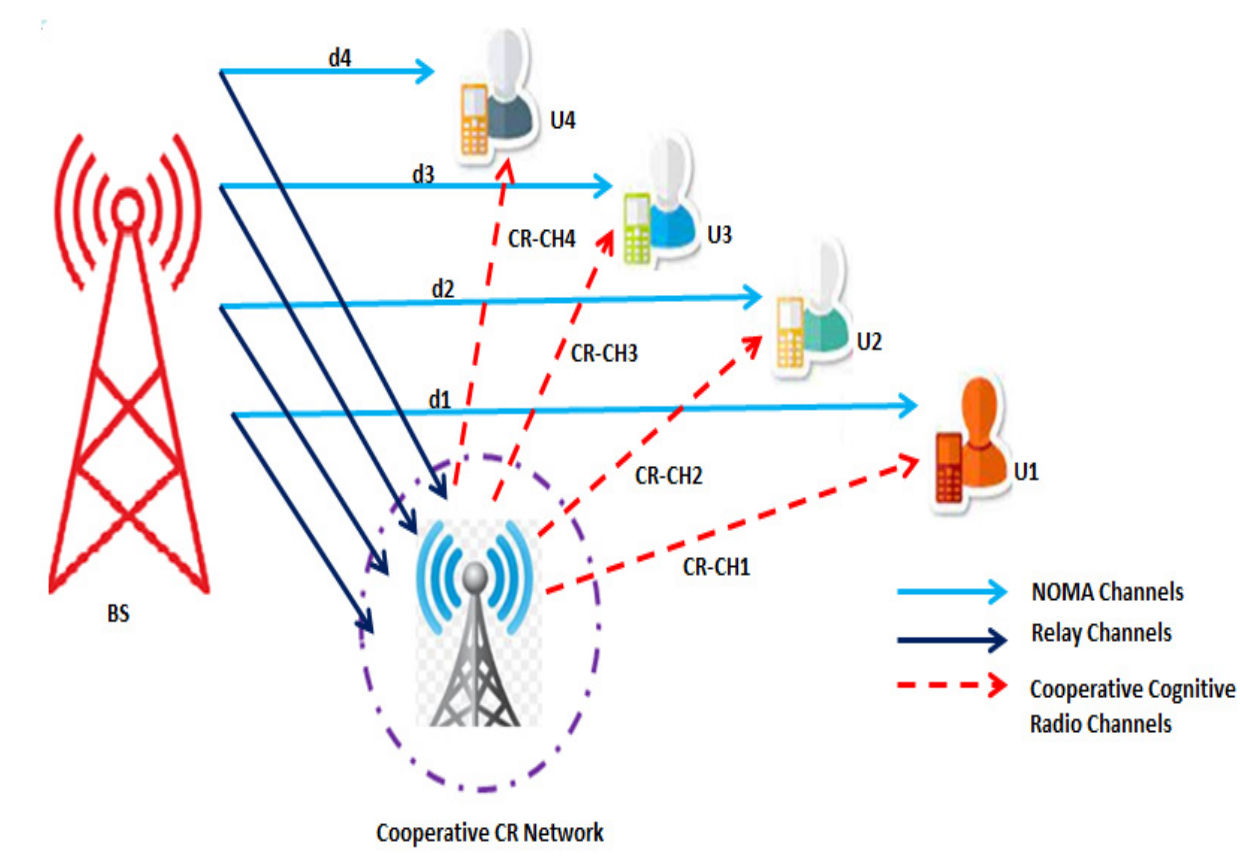
Figure 2. DL-NOMA PD with the CCR network with four users’ system model.